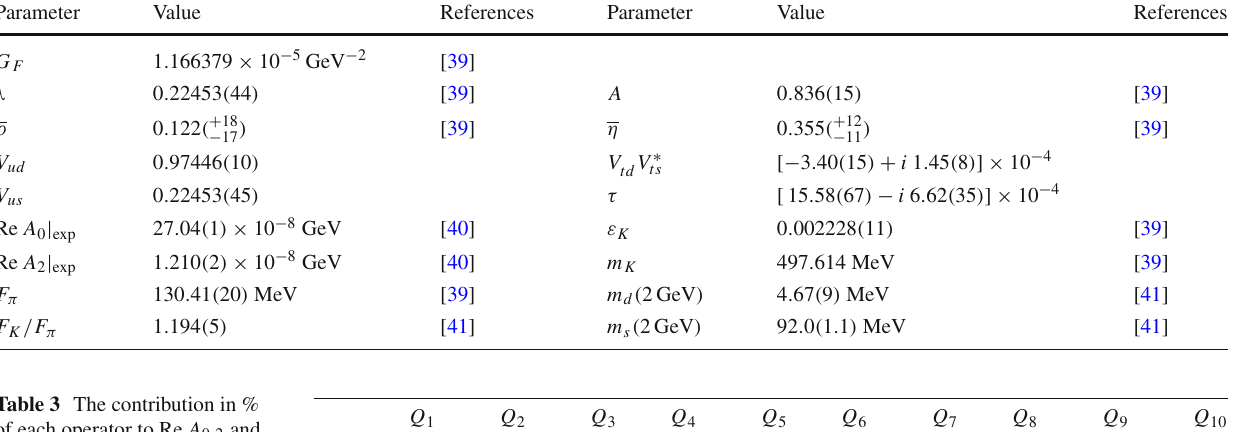
Fig. 1 The μ c dependence [left] and μ W dependence [right] at NLO accuracy of the various quantities normalized to their value at μ c = 1 . 3GeV and μ = 80 . 4GeV, W